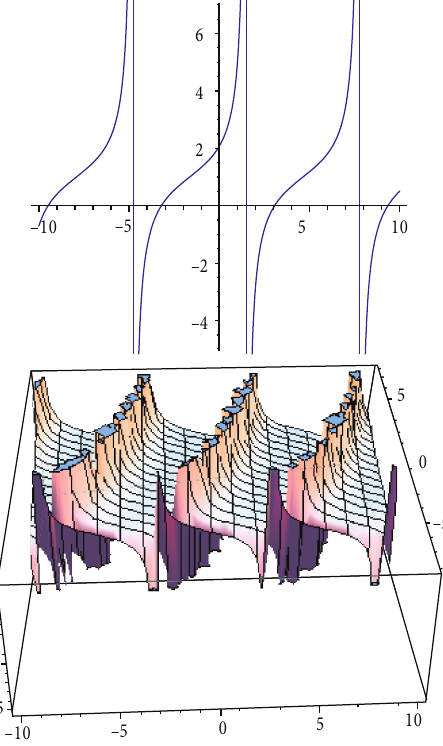
Figure 8: 2D and 3D graphics for trigonometric traveling wave solution (42) at f β = 0 : 5, r = 1, q = 1, c = 1 g